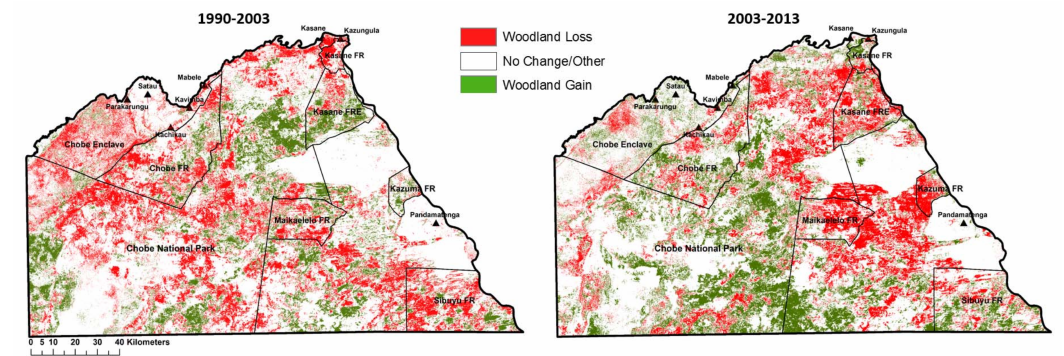
Figure 6. Maps of woodland change from 1990–2003 and 2003–2013. Woodland losses are shown in red and gains in green. White indicates areas of no change or land cover other than woodland.